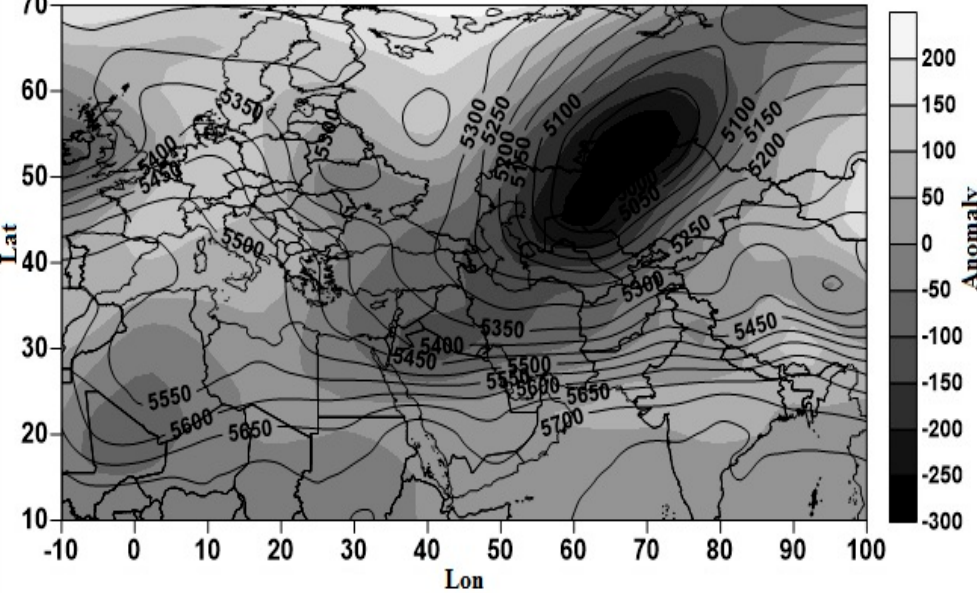
Figure 3. Atmosphere anomalies and thickness (in meters) for the representative days of the first pattern.